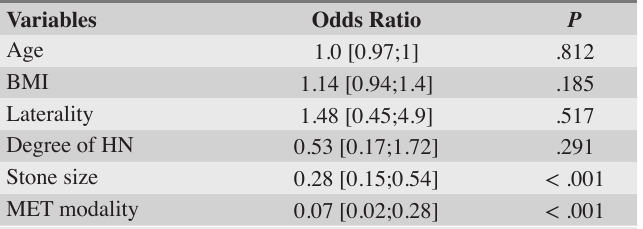
Table 3. Multivariate Logistic Regression Analysis of Predictive Factors of Stone Expulsion Rate in All